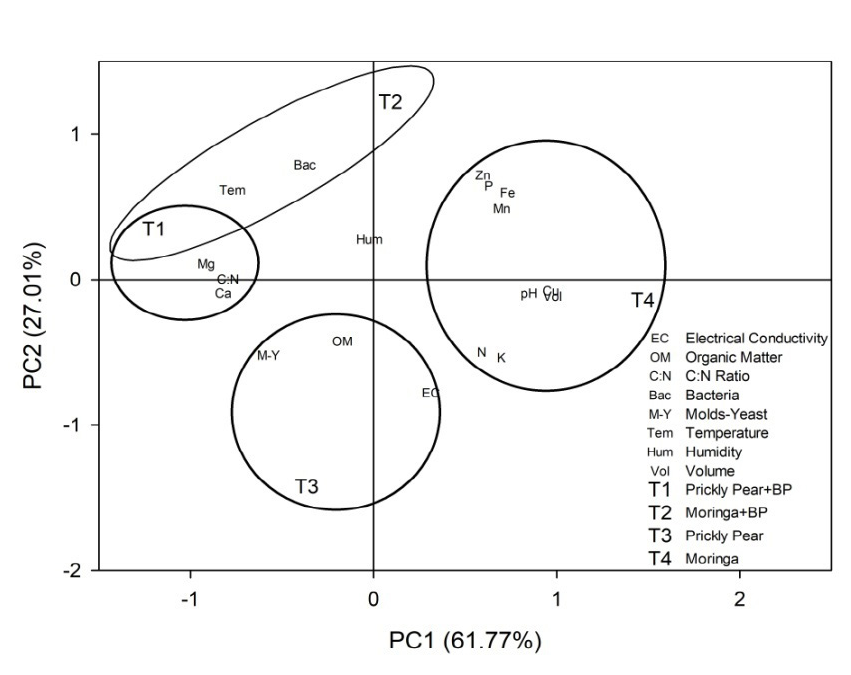
Figure 7: Principal component analysis of physical, chemical and biological variables of static piles. BP: biodynamic preparations, N: nitro- gen; P: phosphorus; K: potassium, Ca: calcium, Mg: magnesium, Cu: copper, Zn: zinc, Fe: iron, Mn: